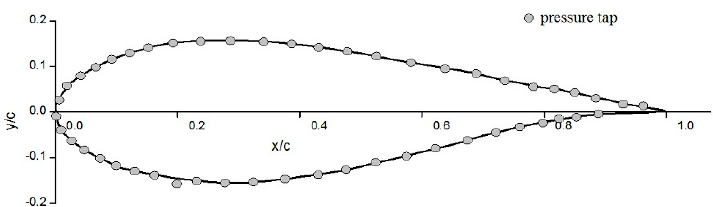
Figure 5. Experimental scheme of the wind tunnel and the testing of the LUT airfoil: ( a ) schematic of the wind tunnel and the experimental devices; and ( b ) experiment section. The cross-section of the wind tunnel is 400 mm × 1000 mm and the length is 2800 mm.